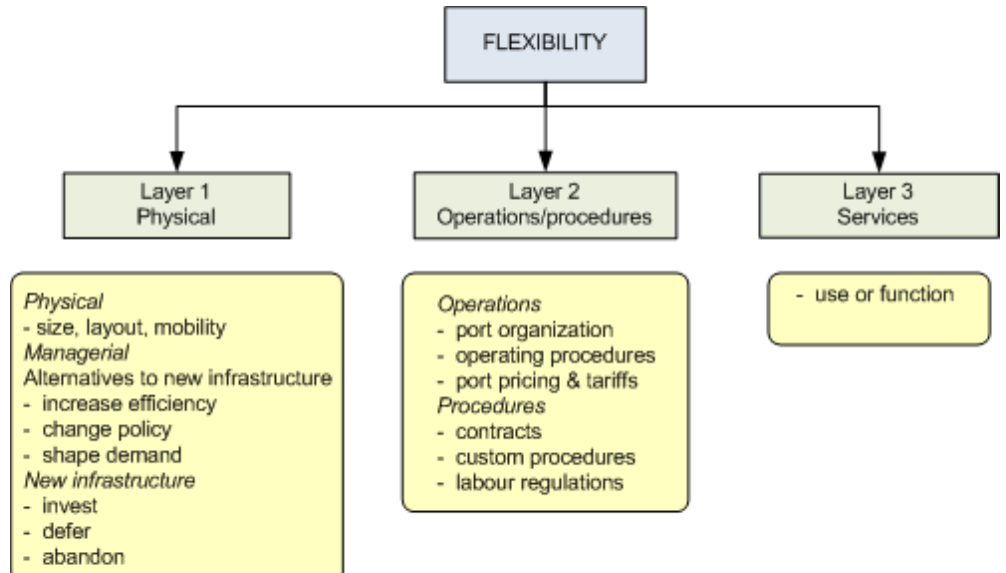
Figure 2. Flexible options available at different levels of the